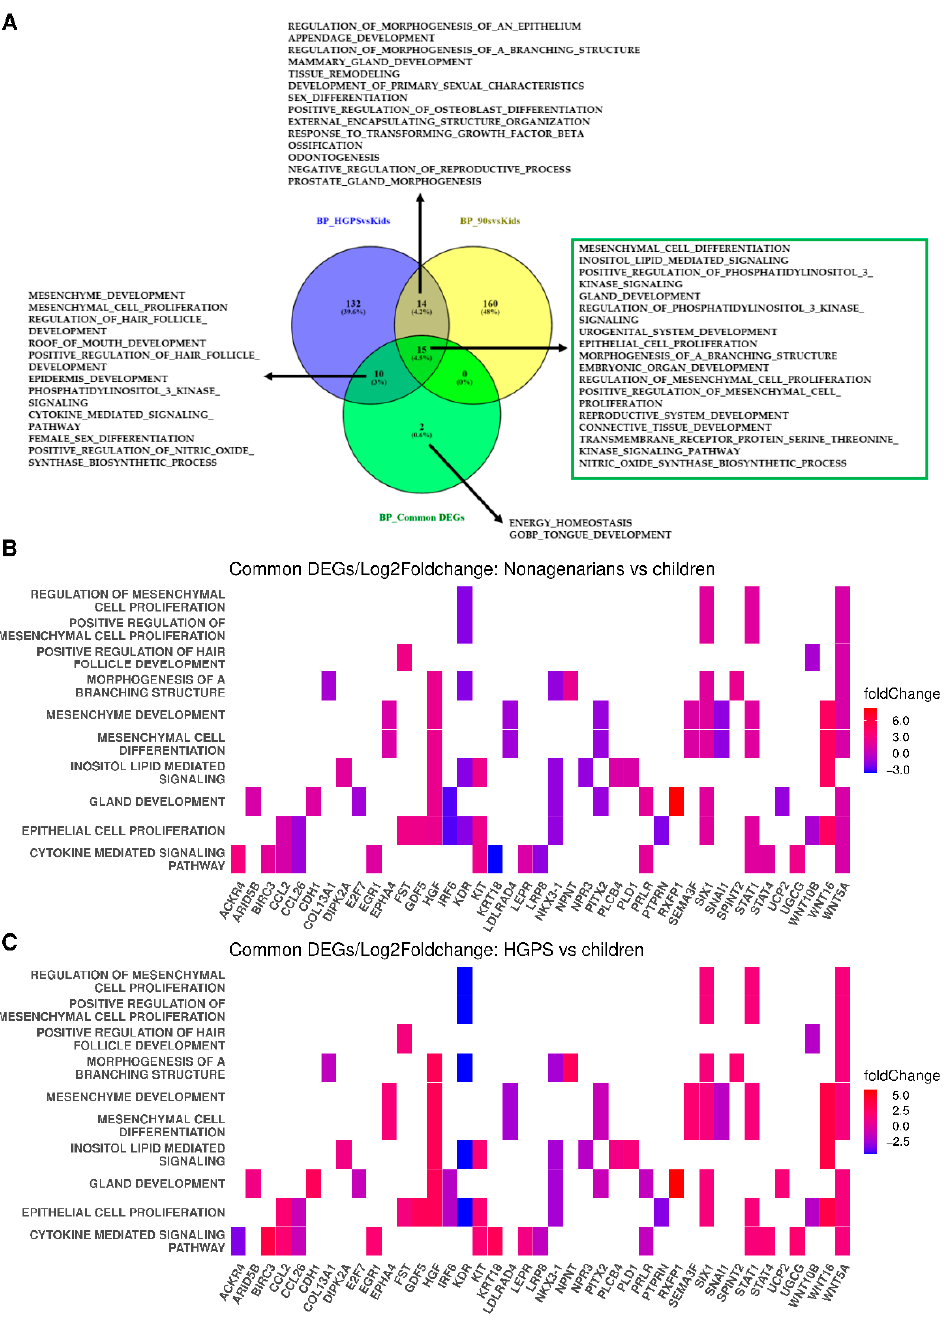
Figure 5. Differences in gene expression between HGPS and aging. ( A ) Venn diagram visualizing the GO BPs enriched in HGPS (blue), aging (yellow), and in the 157 common DEGs of progeria and aging. 15 BPs are enriched in all three analyses. ( B ) Heat plot visualizing the changes in gene ex- pression in the DEGs involved in the 15 BPs using the changes in gene expression observed while comparing nonagenarians and healthy children (log2foldchanges of DESeq2 analysis). ( C ) Heat plot visualizing the changes in gene expression in the DEGs involved in the 15 BPs using the changes in gene expression observed while comparing progeria patients and healthy children (log2foldchanges of DESeq2 analysis). The differences in gene expression are indicated by color (red for upregulated, blue for downregulated). Notably, UCP2, which is involved in gland development, is upregulated in progeria but downregulated in aging. ACKR4, which is involved in the cytokine-mediated sig- naling pathway, is upregulated in aging (comparison of healthy children and nonagenarians) but downregulated in progeria (comparison of healthy children and progeria patients).